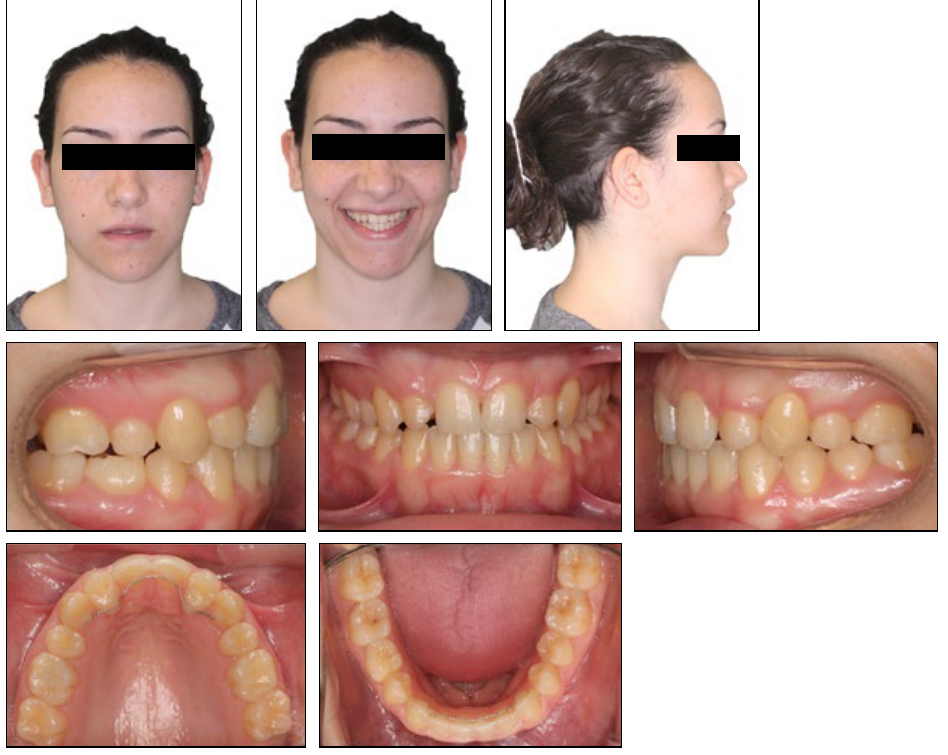
Figure 9. Post-treatment facial and intraoral photographs.